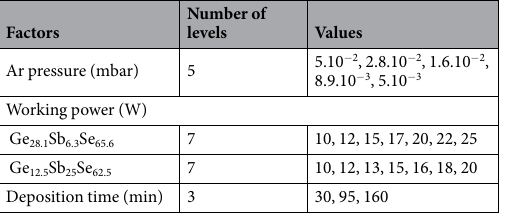
Table 1. Domain of the experimental study of Ge 28.1 Sb 6.3 Se 65.6 and Ge 12.5 Sb 25 Se 62.5 thin films.